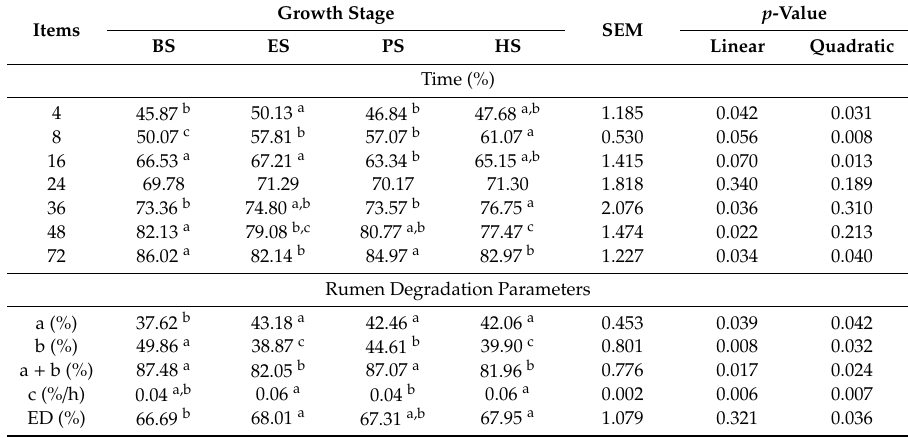
Table 3. Rumen degradability and degradation parameters of CP of amaranth